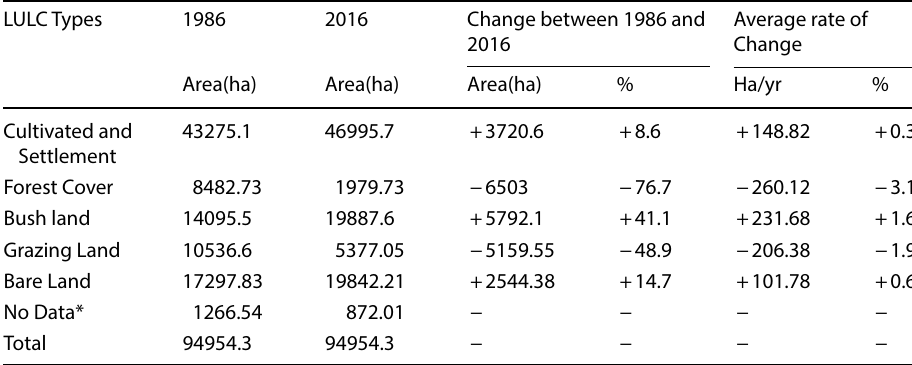
Table 7 Extent and rate of LULC changes between 1986 and 2016 in Gubalafto District